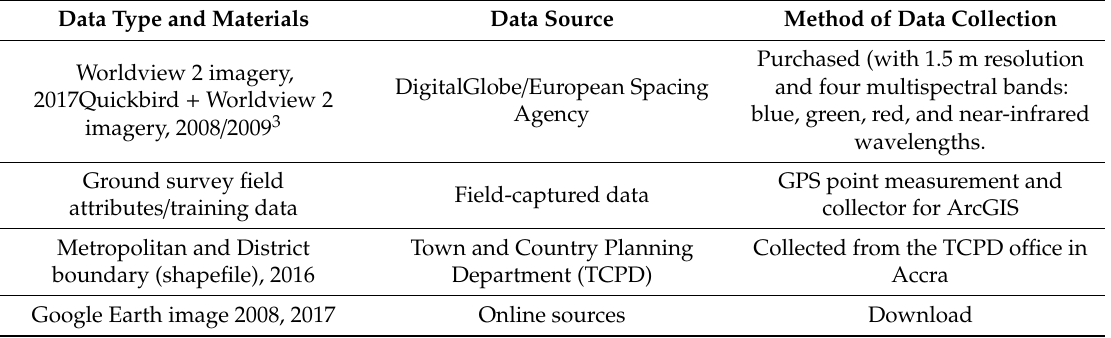
Table 1. Data type, source, and collection